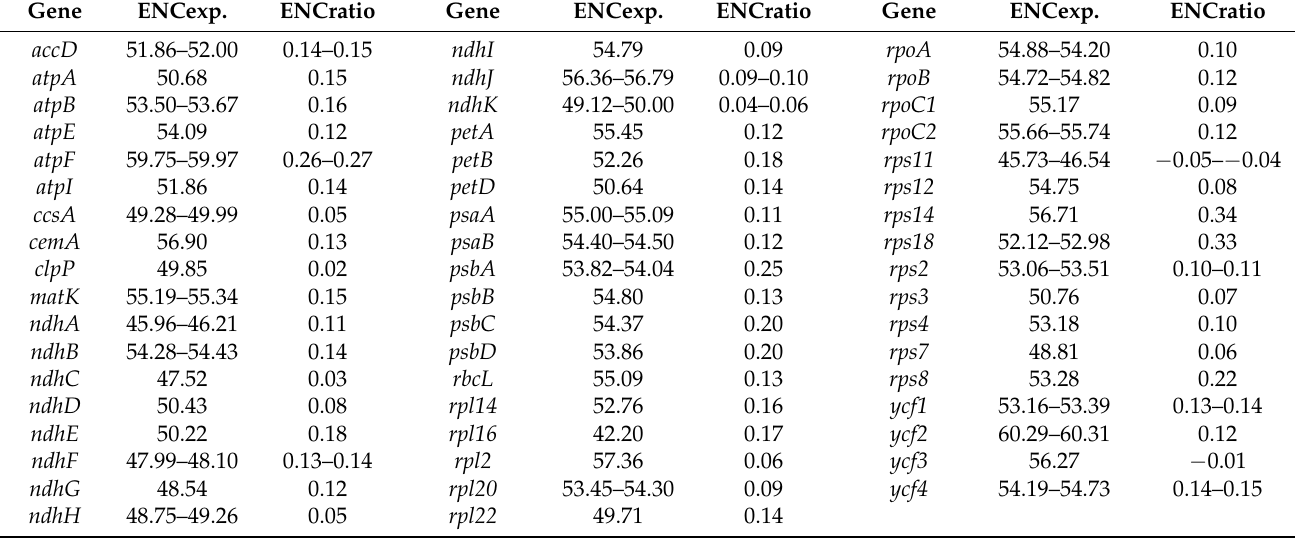
Table 4. ENCexp value and ENCratio of the chloroplast genome of oil-tea camellia.